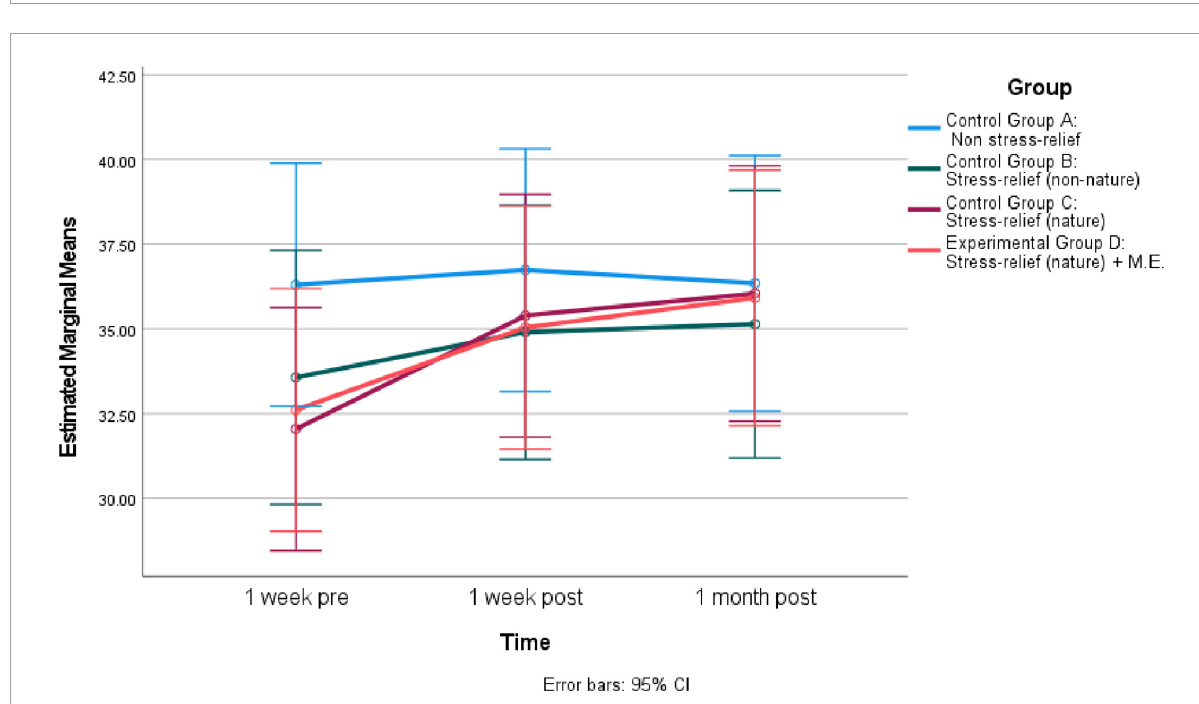
FIGURE5 Estimated marginal means of “Connectedness to nature” across different time for four groups ( N = 90).